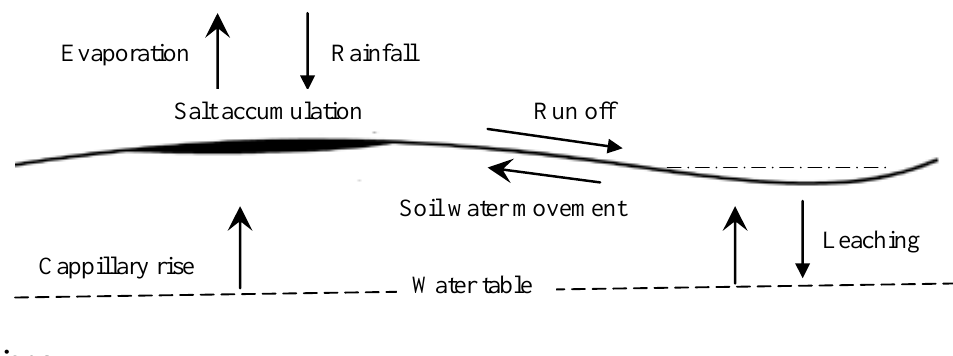
Figure 4. Saline accumulate in subtly undulating